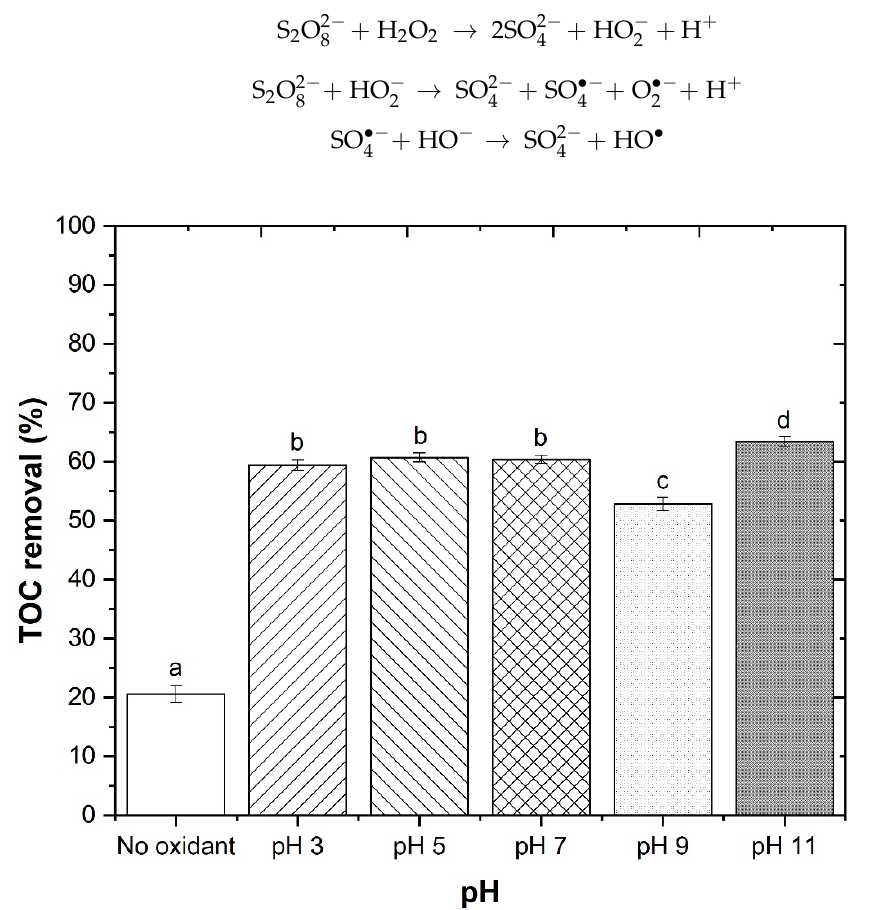
Figure 7. Evolution of TOC removal at different pH (3.0–11.0) in thermocatalytic oxidation, under the following operational conditions: S 2 O 8 2 - /H 2 O 2 ratio = 1:0.25, S 2 O 8 2 - /H 2 O 2 dosage = 0.1:0.025 ( g/g ), T = 333 K, agitation 350 rpm, t = 2 h. A blank experiment under the following operational conditions is also shown as reference: pH = 11.0, T = 333 K, agitation 350 rpm, t = 2 h. Means in bars with different letters represent significant differences ( p < 0.05) between each pH.